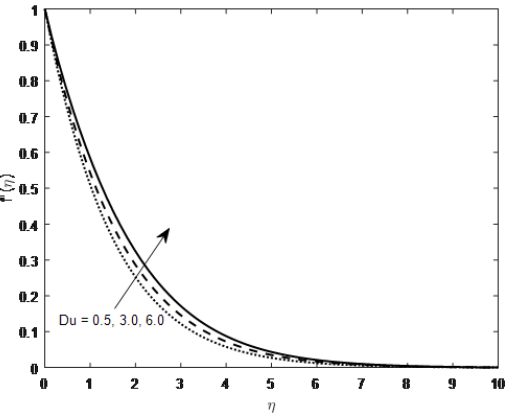
Figure 4: Velocity profiles for different values of Dufour number Du